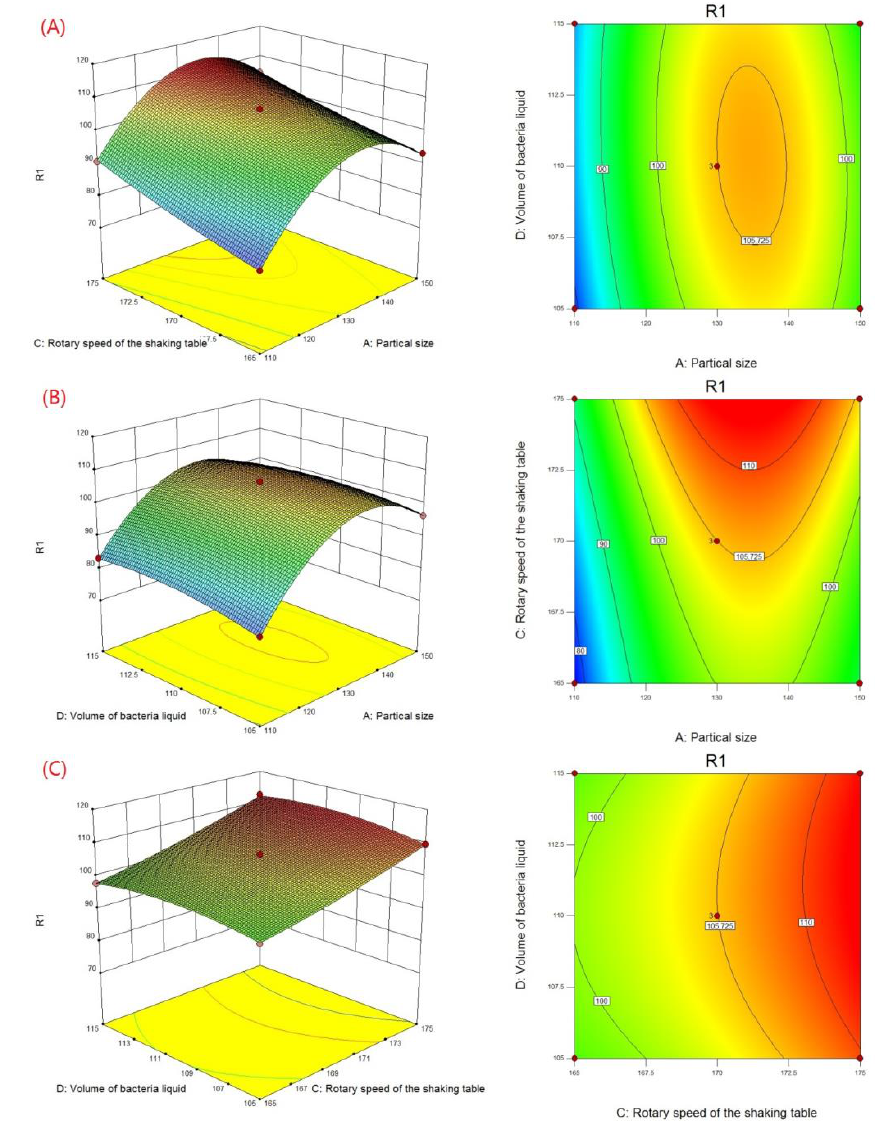
Figure 4. Three-dimensional plots and contour plots showing the effect of ( A ) particle size and rotary speed of shaking table, ( B ) particle size and volume of bacteria liquid, and ( C ) rotary speed of shaking table and volume of bacteria liquid on biodesulfurization.